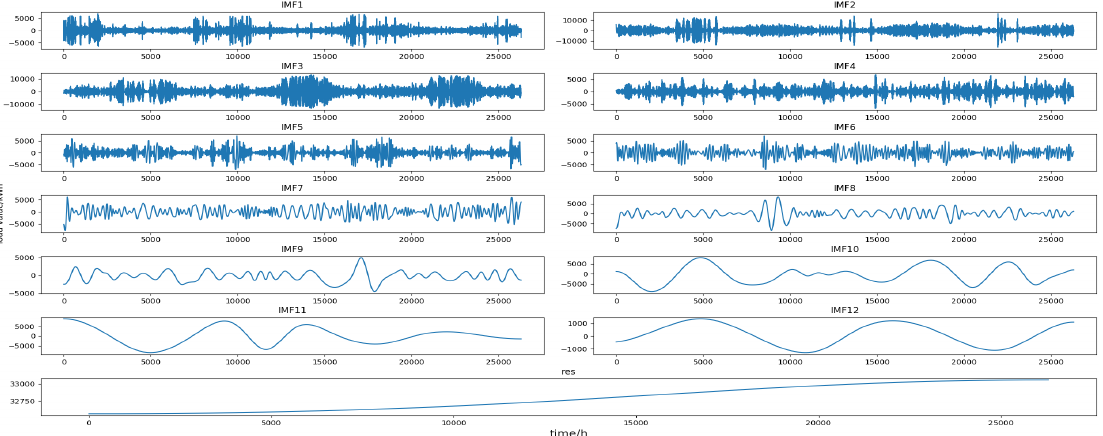
Figure 5. M_1 load series decomposition results.